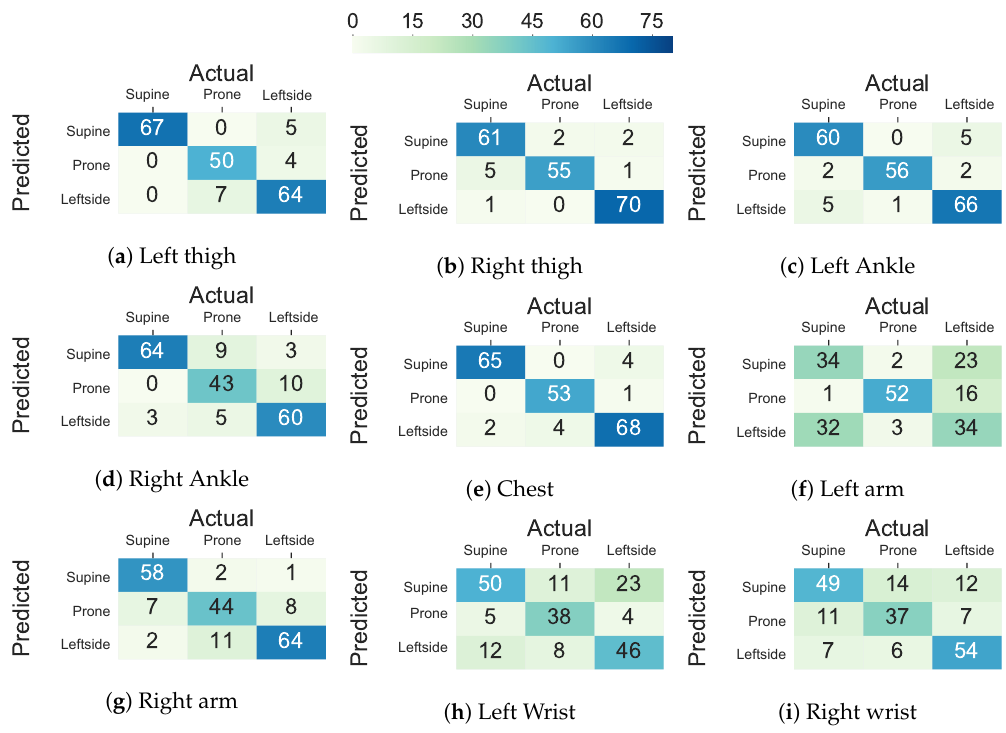
Figure 6. Confusion matrix of the ensemble tree classifier in classifying lying postures into supine, prone, and left side for the thighs, ankles, chest, arms, and wrists locations using Class-Act dataset. Table 3. Performance (%) of the sequence classification using AdaLSTM in lying-posture detection for nine different body locations on the Class-Act dataset using LOSO